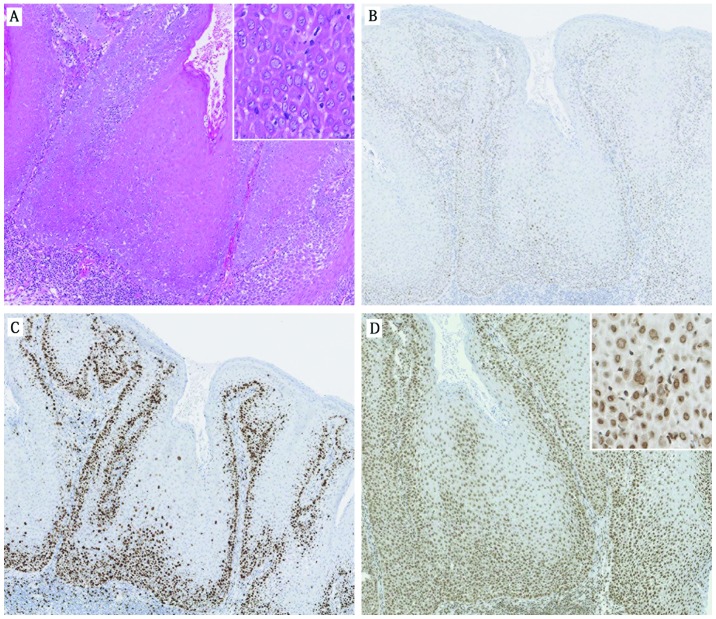
Expression of p53, Ki67 and HuR in oral verrucous carcinoma (OVC). (A) Atypical cells are prominent in the multi-layered basal cells (H&E). (B) p53- and (C) Ki67-positive cells are increased in number and noted in the middle of the epithelium. (D) Cytoplasmic HuR expression is commonly observed in lower two-thirds of the epithelium (A–D, magnification ×10). H&E, hematoxylin and eosin.